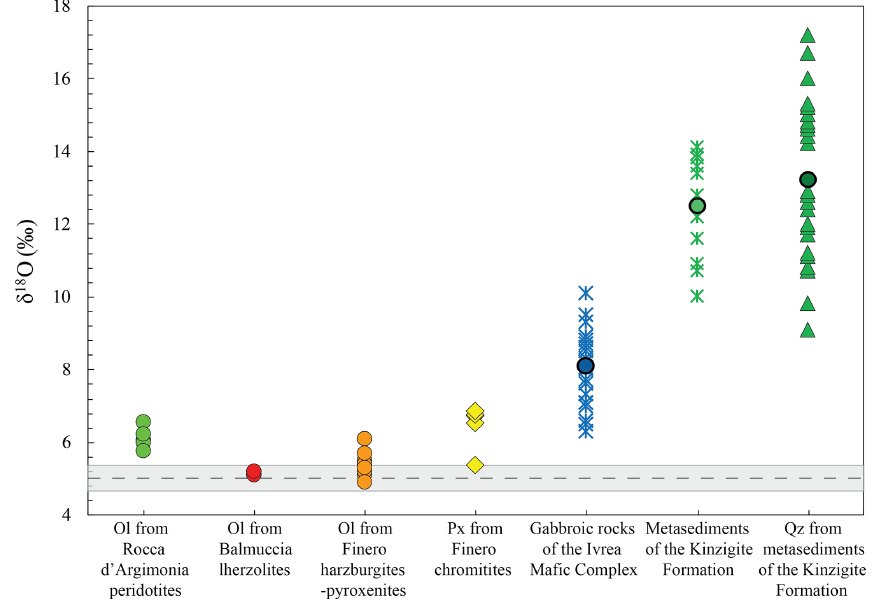
Figure 13. δ 18 O of olivine from the Rocca d’Argimonia peridotites compared with δ 18 O of other minerals/rocks from the Ivrea–Verbano Zone. Olivines from dunites, harzburgites and lherzolites of Rocca d’Argimonia are reported with the same symbol. Olivine from spinel lherzolites of the Balmuccia mantle sequence after Selverstone and Sharp (2011). Olivine from harzburgites and pyroxenites of the Finero mantle sequence after Selverstone and Sharp (2011). Orthopyroxene and clinopyroxene from chromitites of the Finero mantle sequence after Zanetti et al. (2016). Gabbroic rocks from the Ivrea Mafic Complex after Sinigoi et al. (1991, 1994); the dot represents the mean value of + 8.1‰. Metasediments of the Kinzigite Formation after Schnetger (1994); the dot represents the mean value of + 12.5‰. Quartz from metasediments of the Kinzigite Formation after Baker et al. (1990); the dot represents the mean value of + 13.2‰. The grey field represents the δ 18 O of typical mantle olivines (Mattey et al., 1994). Mineral abbreviations after Whitney and Evans (2010).